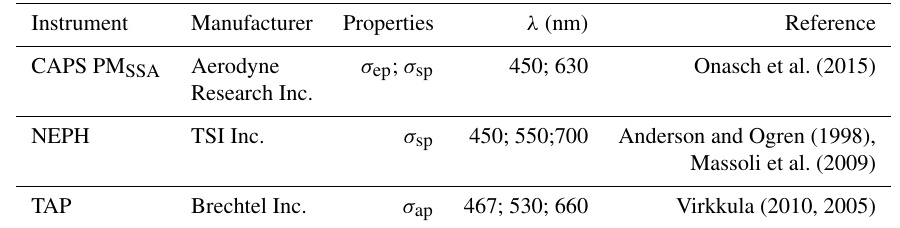
Organic pigments MB Unknown Table 2. List of applied correction algorithms to optical instruments. Instrument Manufacturer